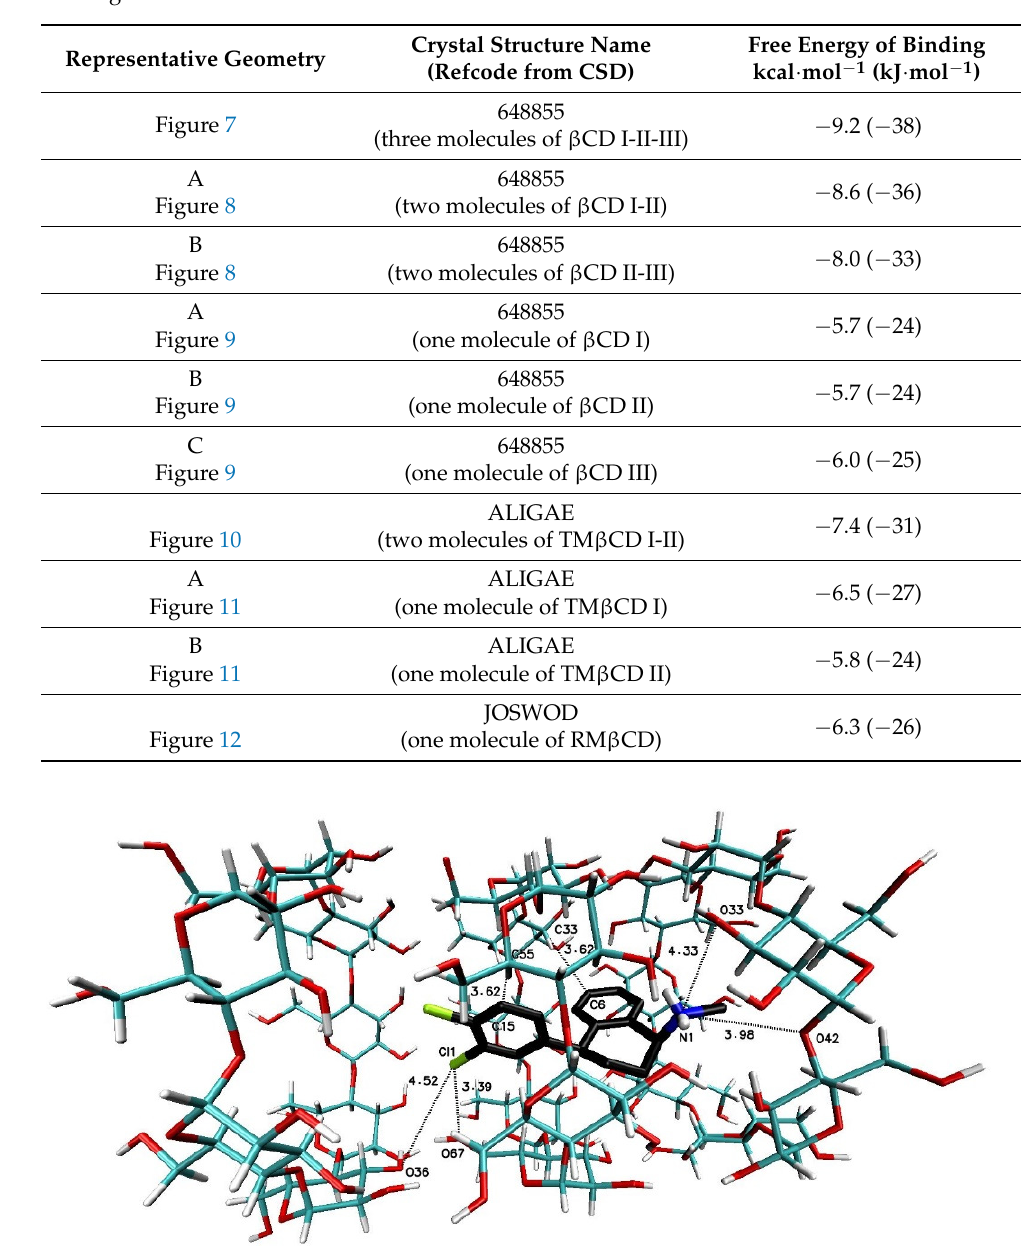
Figure 8. The geometries of the SRT- β CD complex with stoichiometry 1:2 (I-II for ( A ) or “head-to-head” [69,70] and II-III or “head-to-tail” for ( B ) obtained by MD simulations with the use of β CD crystal structure with refcode 648855 [67] from the CSD database [47].